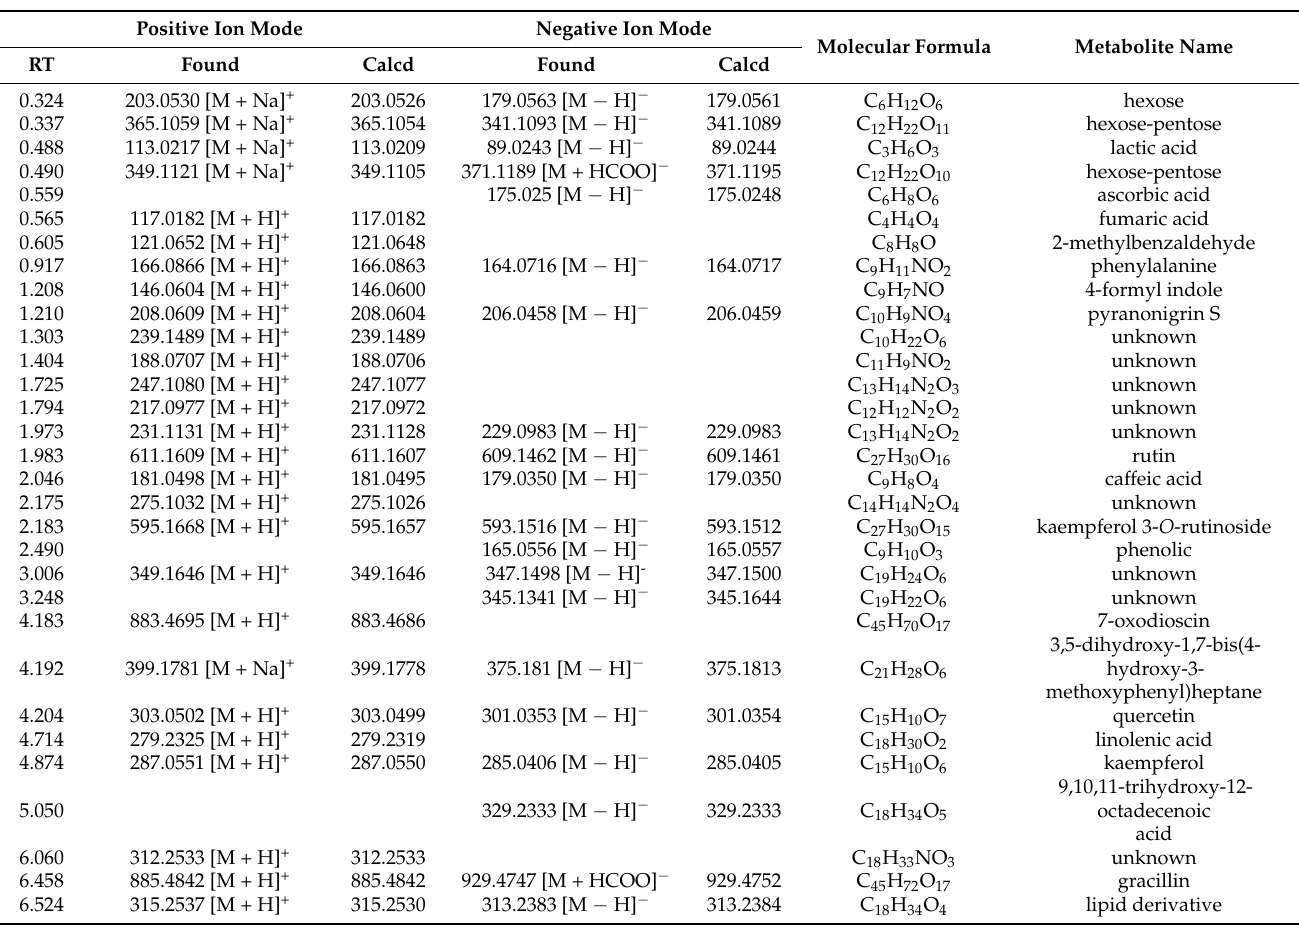
Table 8. LC-MS of butanol